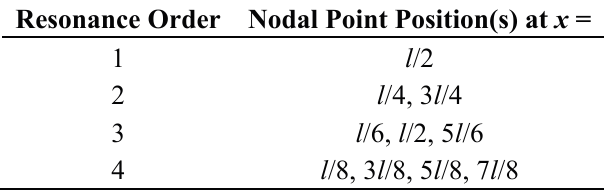
Figure 2. The motion patterns of an MS with different mass load distribution ( a / l ) for ( a ) first order resonance mode; ( b ) second order resonance mode; ( c ) third order resonance mode; and ( d ) fourth order resonance mode. Here, ρ m A m / ρ s A s = 1 is used for easy distinction of each pattern. Table 2. The “nodal point” position for the MS with a / l = 0 and a / l = 1. Resonance